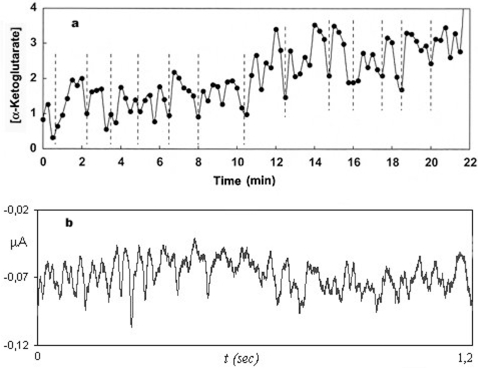
Chaotic behaviors in two different metabolic subsystems.(a) Experimental oscillations belonging to the citric acid cycle, a metabolic subsystem always active under cellular conditions (MacDonald et all, 2003), the α-ketoglutarate concentration is represented as a function of the time t. (b) Experimental calcium oscillations in oocytes carried out by our group. Application of Fetal Bovine Serum (FBS) (Sigma-Aldrich) diluted 1∶1000 to a Xenopus laevis oocyte promotes the generation of inward Ca2+-dependent Cl− oscillating currents. The trace shown here corresponds to a stable phase of the whole current. These chaotic oscillations represent the activity of a subsystem in an active-inactive changeable regime. The amplitude (μA) is represented versus time.